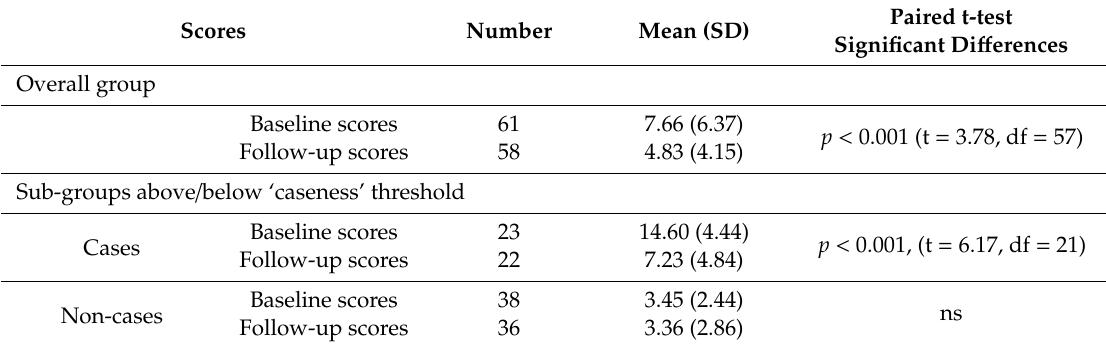
Table 3. PHQ-9-assessed depression scores for the whole group and for sub-groups above the ‘caseness’ threshold ( ≥ 10) and below the threshold ( < 10) at baseline and 6-month follow-up with paired t-test significant di ff